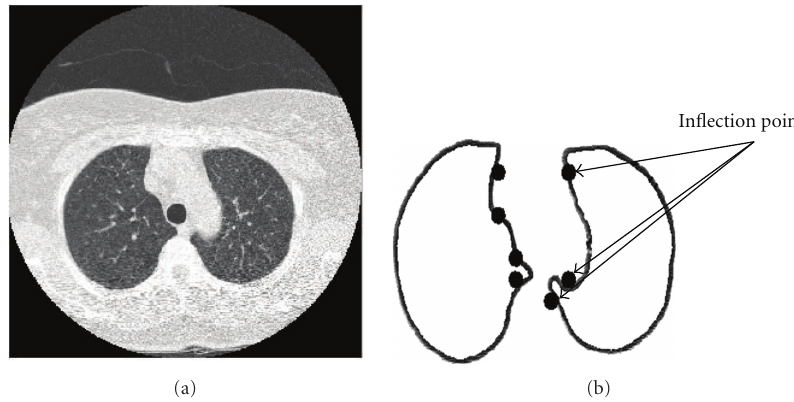
Figure 9: Pleural surface: (a) slice of a whole lung scan, (b) outline from a slice of a whole lung scan.